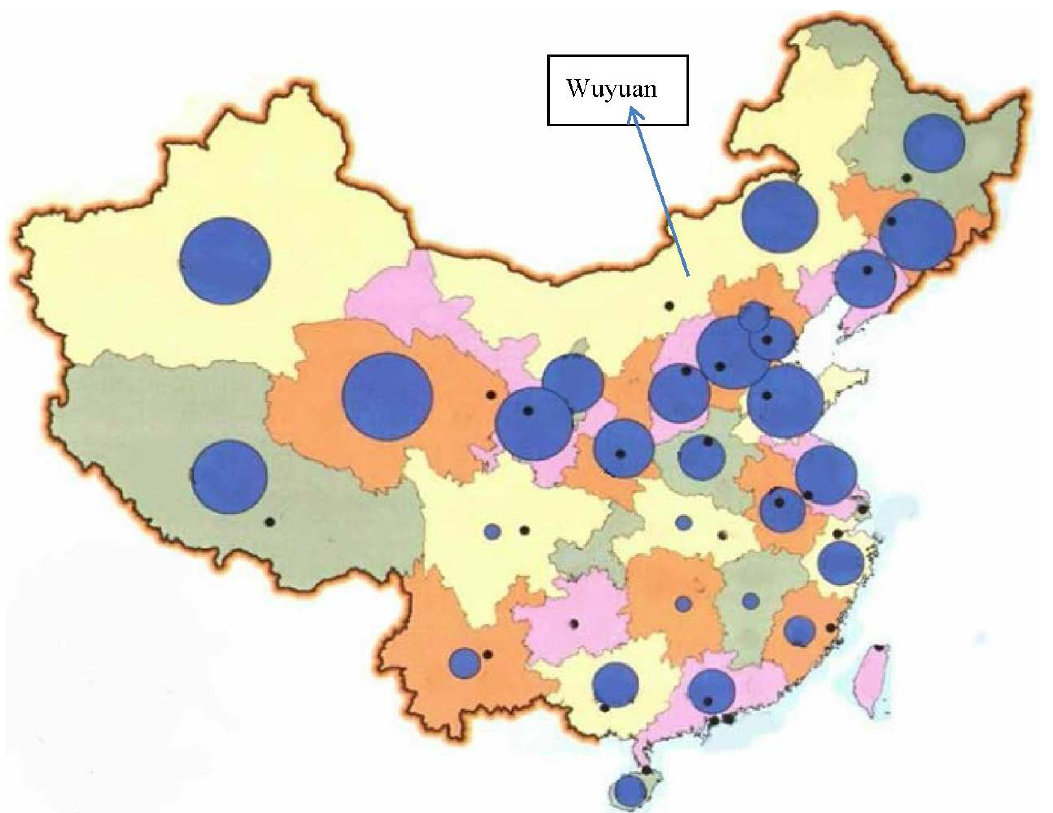
Figure 5. China’s saline and sodic